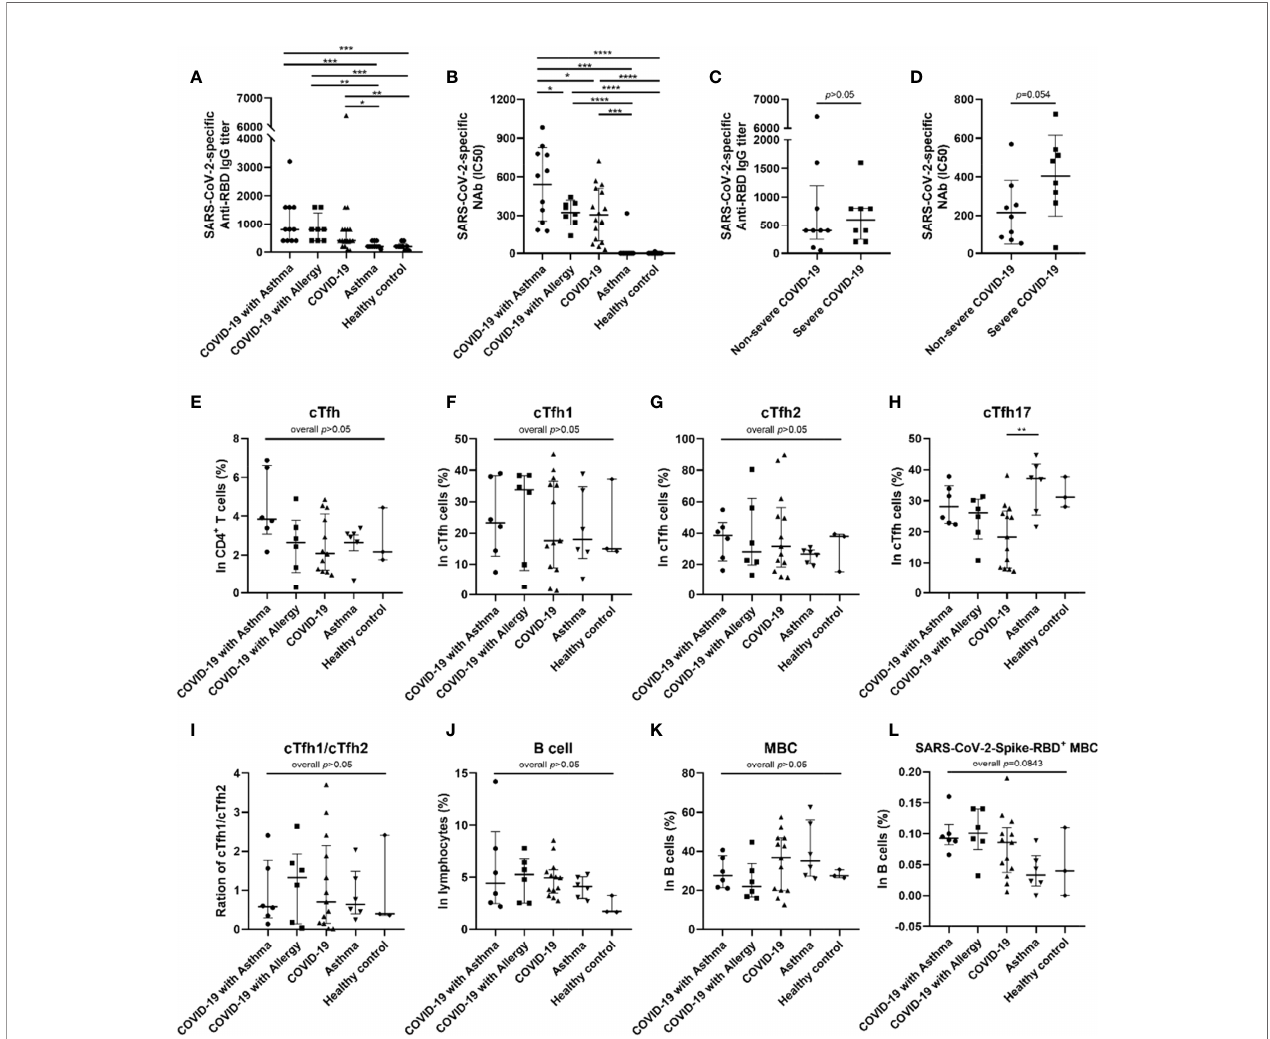
FIGURE 3 | SARS-CoV-2-speci fi c antibodies and frequency of cTfh and memory B cells in peripheral blood of subjects. Anti-SARS-CoV-2 RBD antibody titer was compared among fi ve groups (A) (COVID-19 with asthma n = 11, COVID-19 with allergy n = 8, COVID-19 n = 17, asthma n = 10, healthy control n = 9). The half- maximal inhibitory concentration (IC50) of SARS-CoV-2-speci fi c neutralizing antibodies (NAbs) was compared among fi ve groups (B) . The median of anti-RBD IgG titer (C) and mean of IC50 (D) of patients recovering from severe COVID-19 (n = 8) were higher than that of patients with non-severe COVID-19 (n = 9). The frequency of cTfh cells (E) and B cells (J) were detected and compared in COVID-19 with asthma group (n = 6), COVID-19 with allergy group (n = 6), COVID-19 group (n = 13), asthma group (n = 6), and healthy control group (n = 3). (F – I) Frequency of cTfh1, cTfh2, and cTfh17 cells in cTfh cells was compared among different groups. (K, L) The percentages of memory B cells and SARS-CoV-2 RBD + memory B cells were compared among the fi ve groups. Statistical analysis was performed using Kruskal – Wallis test or Welch ANOVA tests using Graphpad Prism software. For statistical comparisons between the severe and non-severe groups, unpaired t-tests were performed. * p < 0.05, ** p < 0.01, *** p < 0.001, **** p <